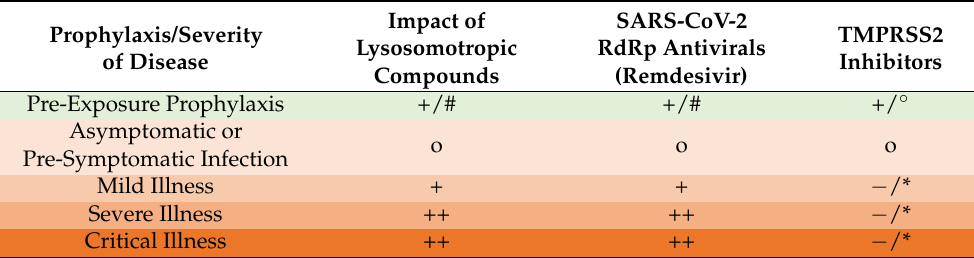
Table 1. Potential scope of approved lysosomotropic drugs, RNA-dependent RNA polymerase (RdRp) severe acute respiratory syndrome coronavirus 2 (SARS-CoV-2) antivirals (remdesivir), and transmembrane serine protease 2 (TMPRSS2) inhibitors (nafamostat, camostat), in the